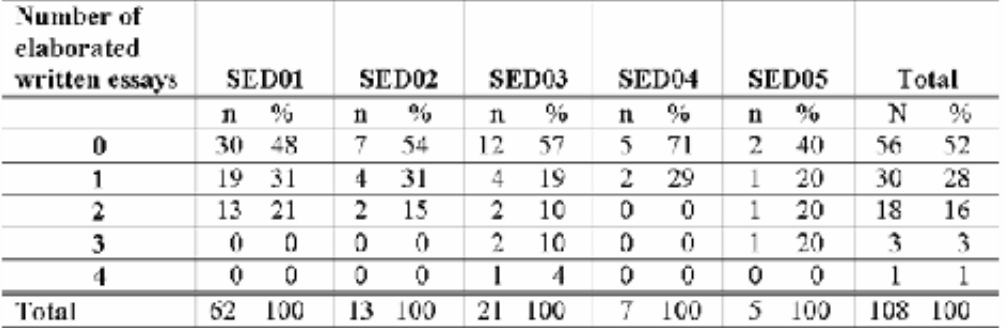
Table 6. Number of written essays completed prior to dropping out